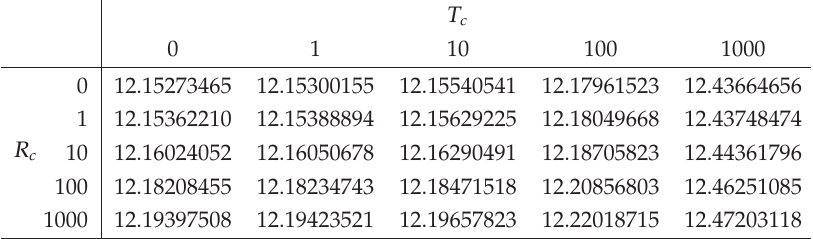
Table 5.6 . Values of coe ffi cients λ the intermediate point elastically restrained against rotation and